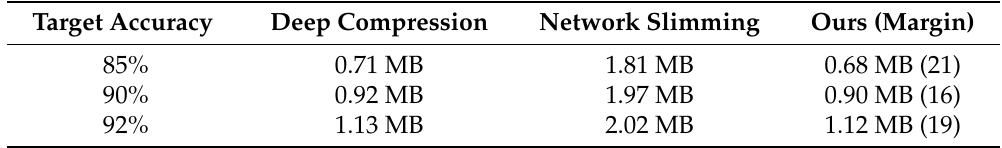
Table 4. The sizes of the minimized models in the corresponding accuracies derived from the proposed method and the individual cases of network slimming and deep compression for DenseNet-40.